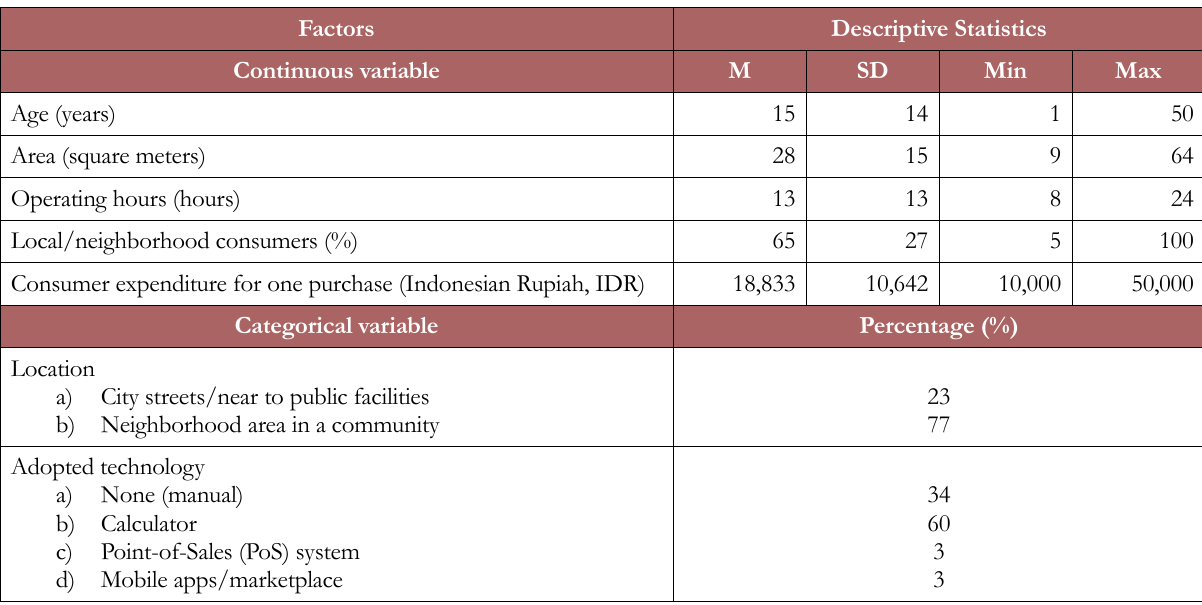
Table 3. The sample